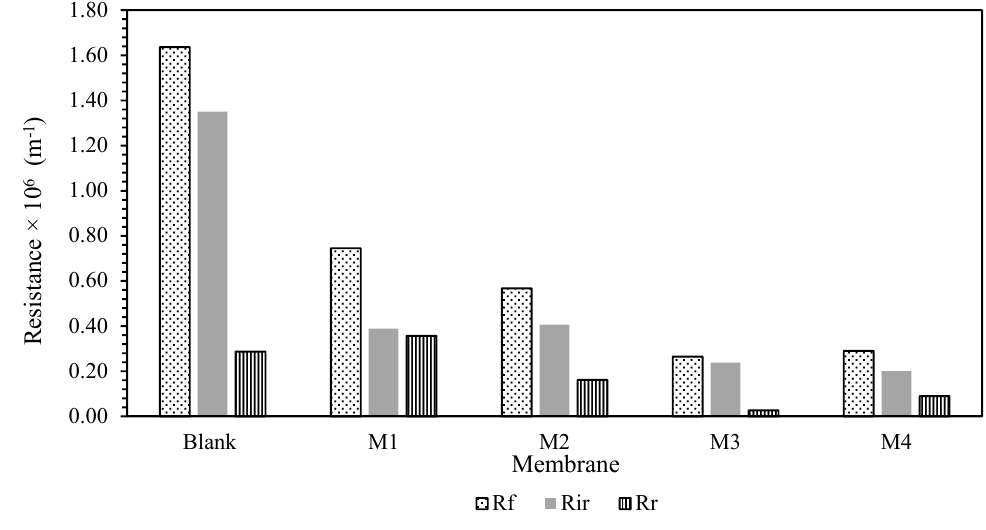
Figure 7. R f , R r , and R ir of the membrane samples.